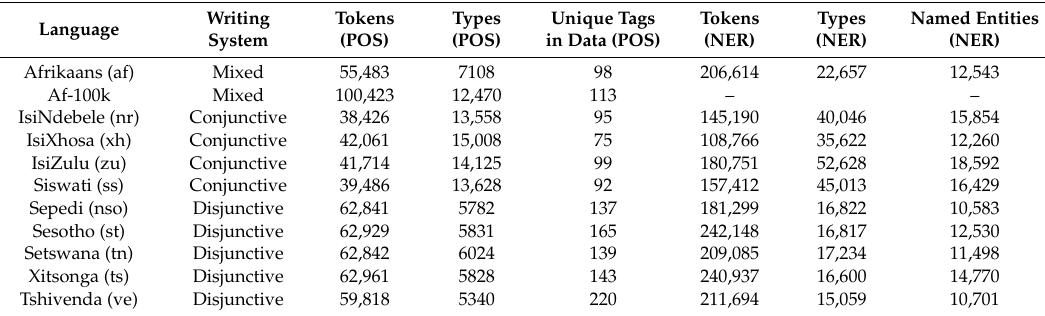
Table 1. POS tagging and NER training data